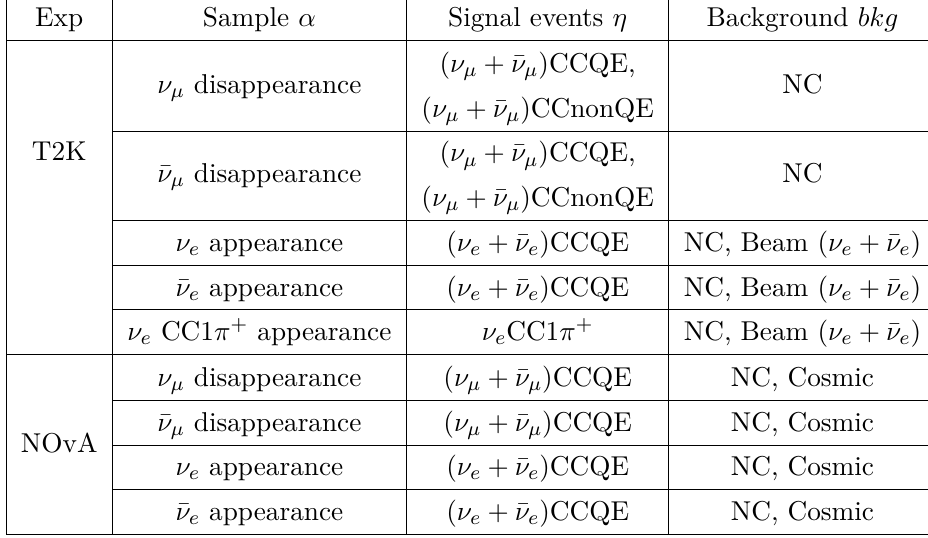
Table 2 . Summary table of data samples of long-baseline accelerator